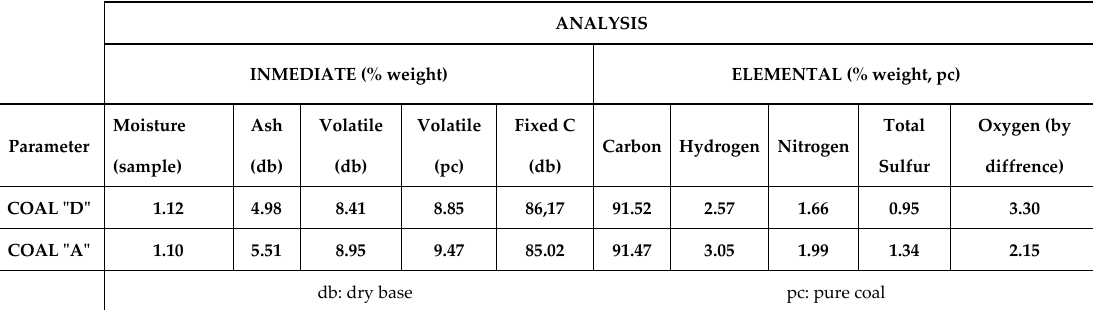
Table 2. Characterization of the two types of coal “D” and